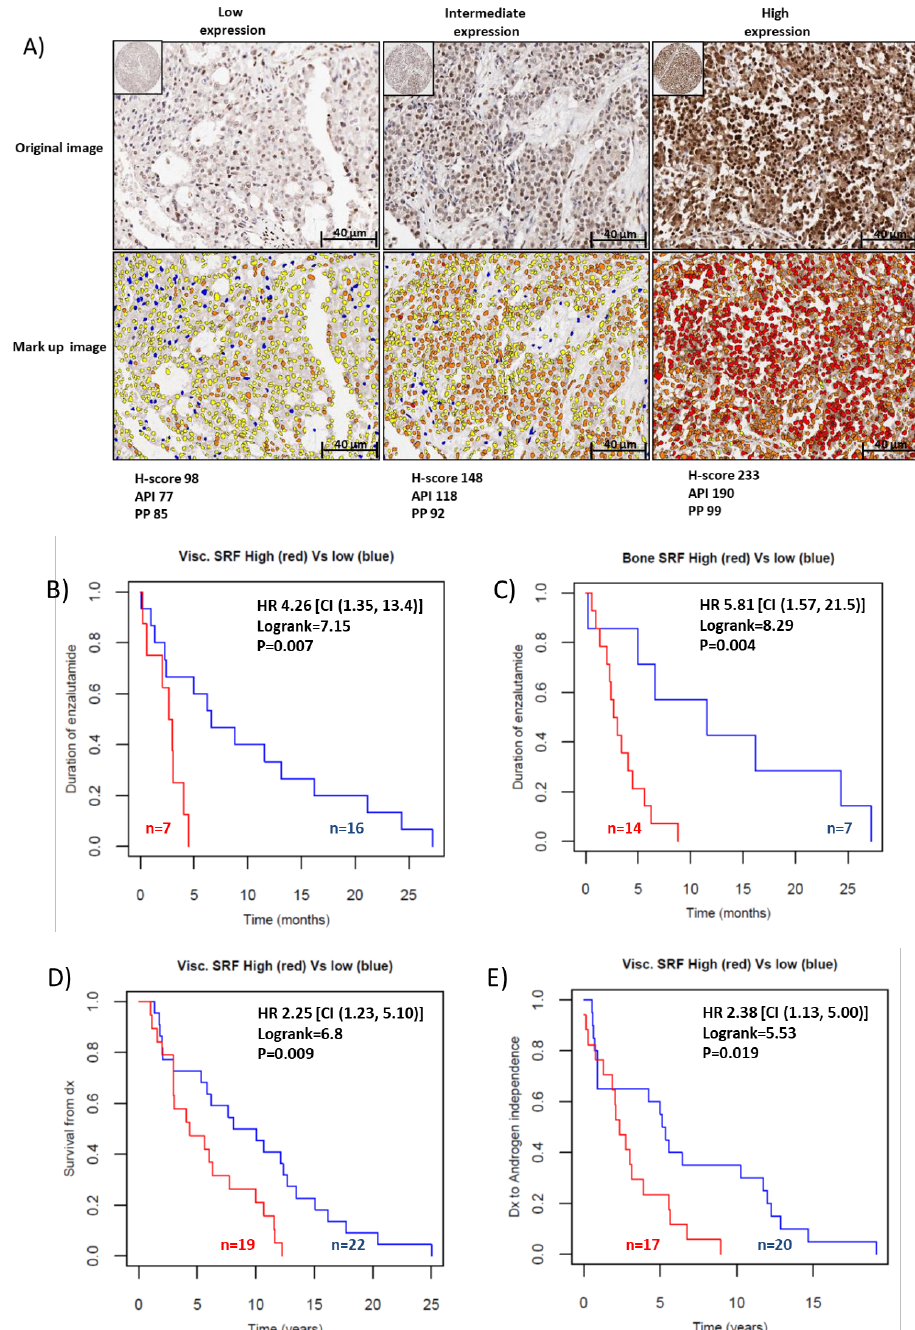
Figure 5. IHC staining for SRF was performed as described in the methods section. ( A ) Representative images of SRF staining with low, intermediate and high SRF nuclear protein expression. Top panel